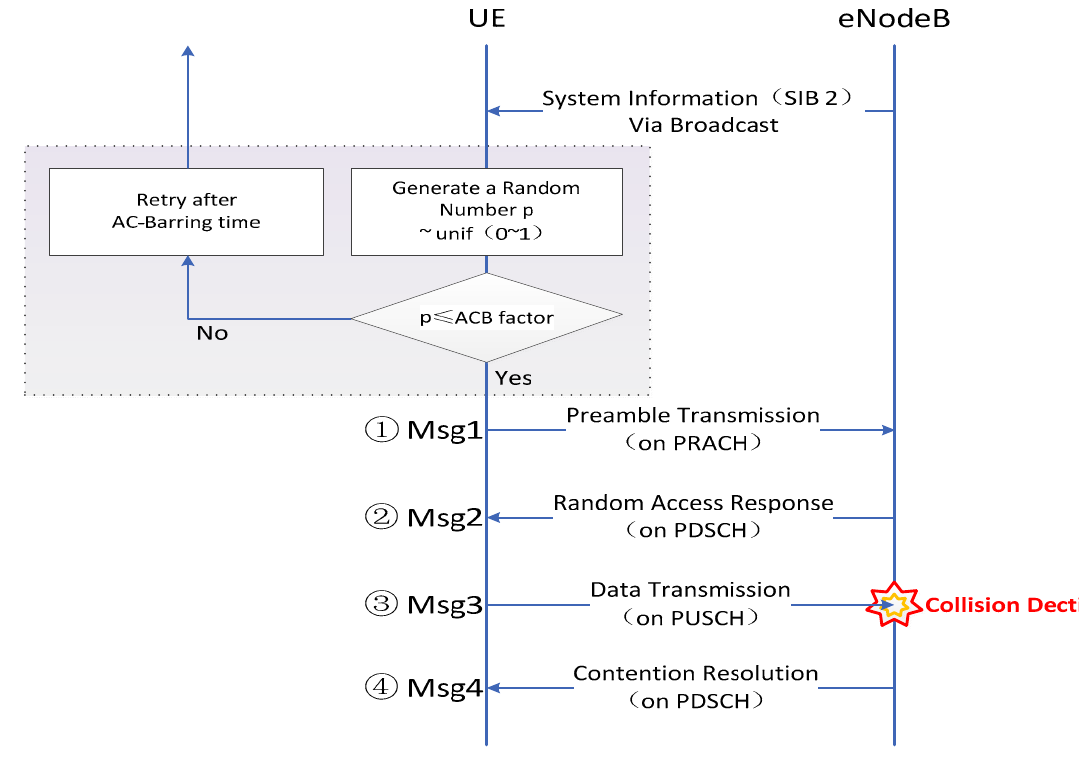
Figure 1. Random access procedure through ACB mechanism.